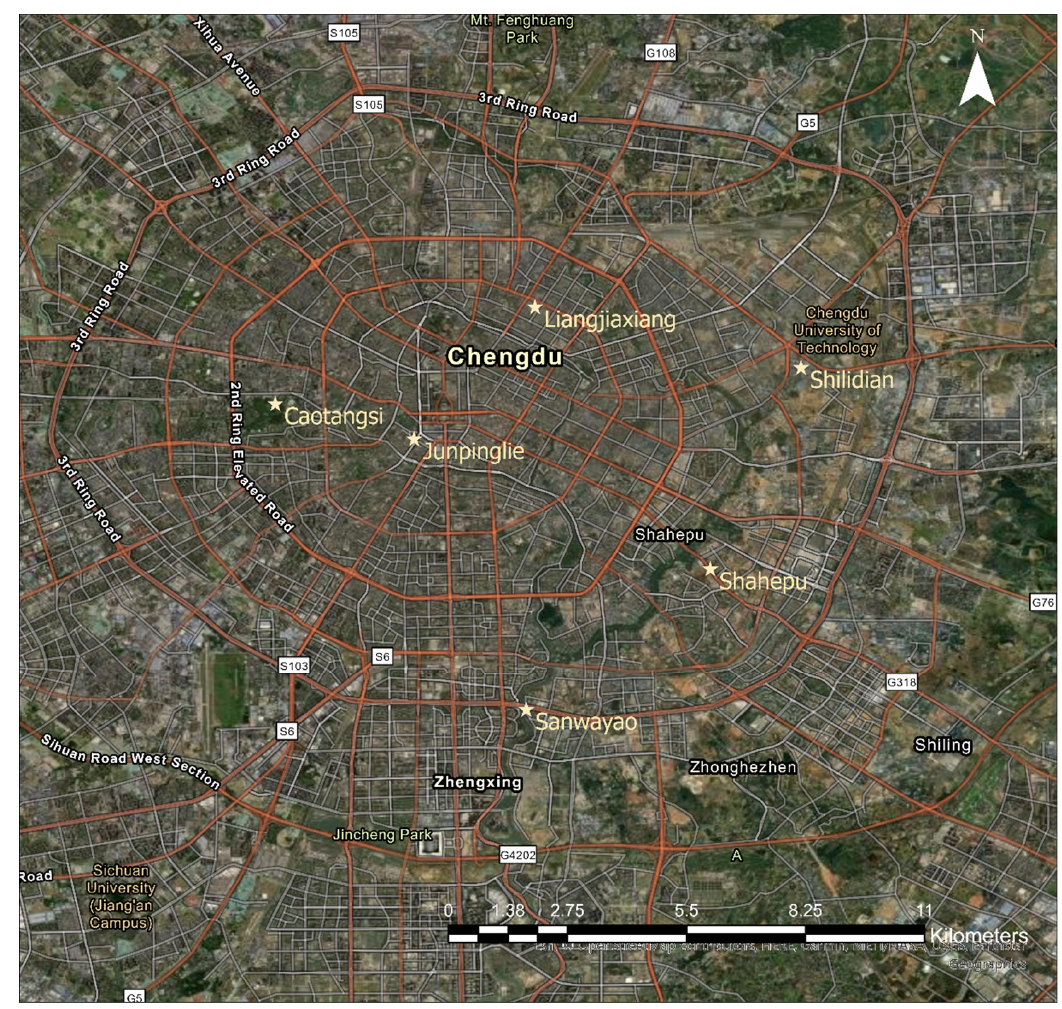
Figure 3. The geographical location of the ground monitoring stations in Chengdu.